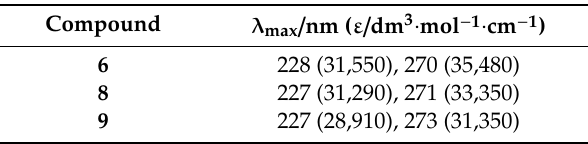
Figure 1. The solution absorption spectrum of compounds 6 , 8 and 9 (MeCN, see Table 2).